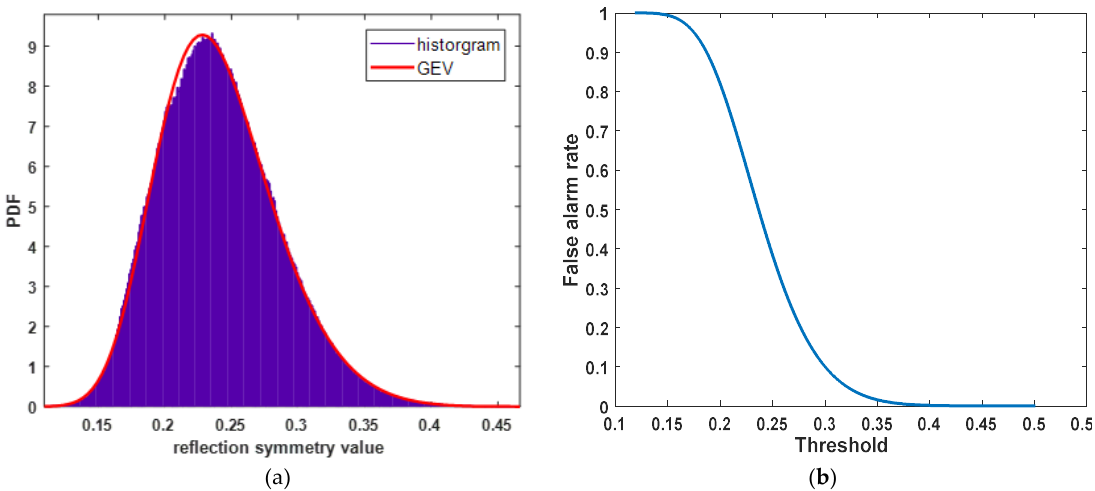
Figure 9. ( a ) VH amplitude; ( b ) VV amplitude; ( c ) reflection symmetry metric; ( d ) polarimetric entropy; ( e ) polarimetric scattering angle; ( f ) detection result; ( h ) detection results comparison with ROC curves.